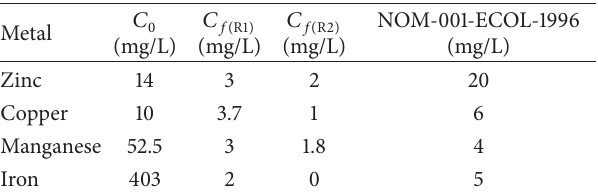
Table 2: Removal of heavy metals in reactors with yeast immobi- lized into